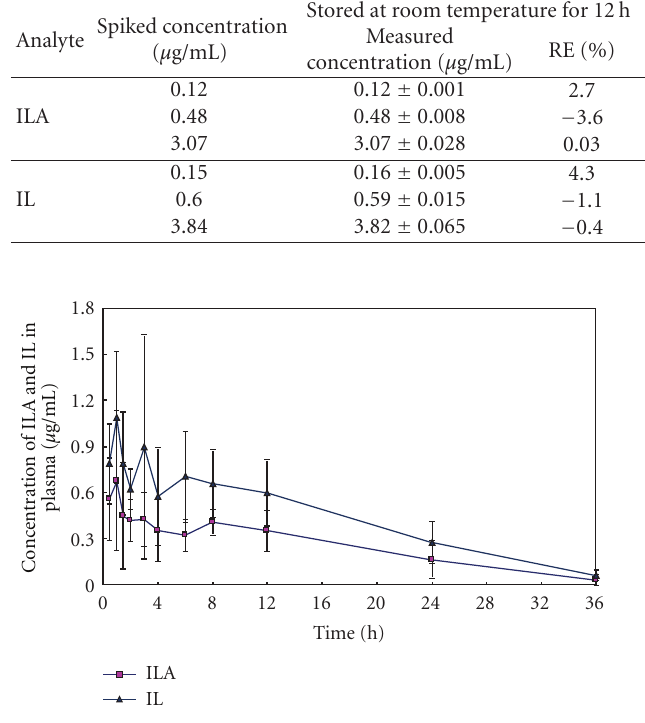
Figure 3: Mean plasma concentration-time profiles ( n = 6) after an oral administration of Zhigancao extract. Table 3: Pharmacokinetic parameters of ILA and IL in following an oral administration of Zhigancao extract. The C max was the measured maximal concentration of ILA and IL, and the t max was the time to reach maximal concentration of ILA and IL, obtained directly from the observed value. Plasma concentrations in the terminal phase for each subject were fit to a log-linear regression by the method of least squares to obtain the elimination rate constant ( k e ). The t 1 / 2 z value was calculated with the following formula: t 1 / 2 = ln(2)/ k e . The AUC 0– t value was the area under the concentration-time curve from 0 to 36 h (calculated using the linear trapezoidal rule), and AUC 0– ∞ value was calculated using the formula: AUC 0– ∞ = AUC 0– t + C last / k e , where C last was the last measurable concentration. The mean residence time (MRT) was obtained from the formula AUMC/AUC (AUMC-area under the concentration × time curve), and MRT 0– ∞ was calculated using the formula: MRT 0– ∞ = AUMC 0– ∞ / AUC 0– ∞ .